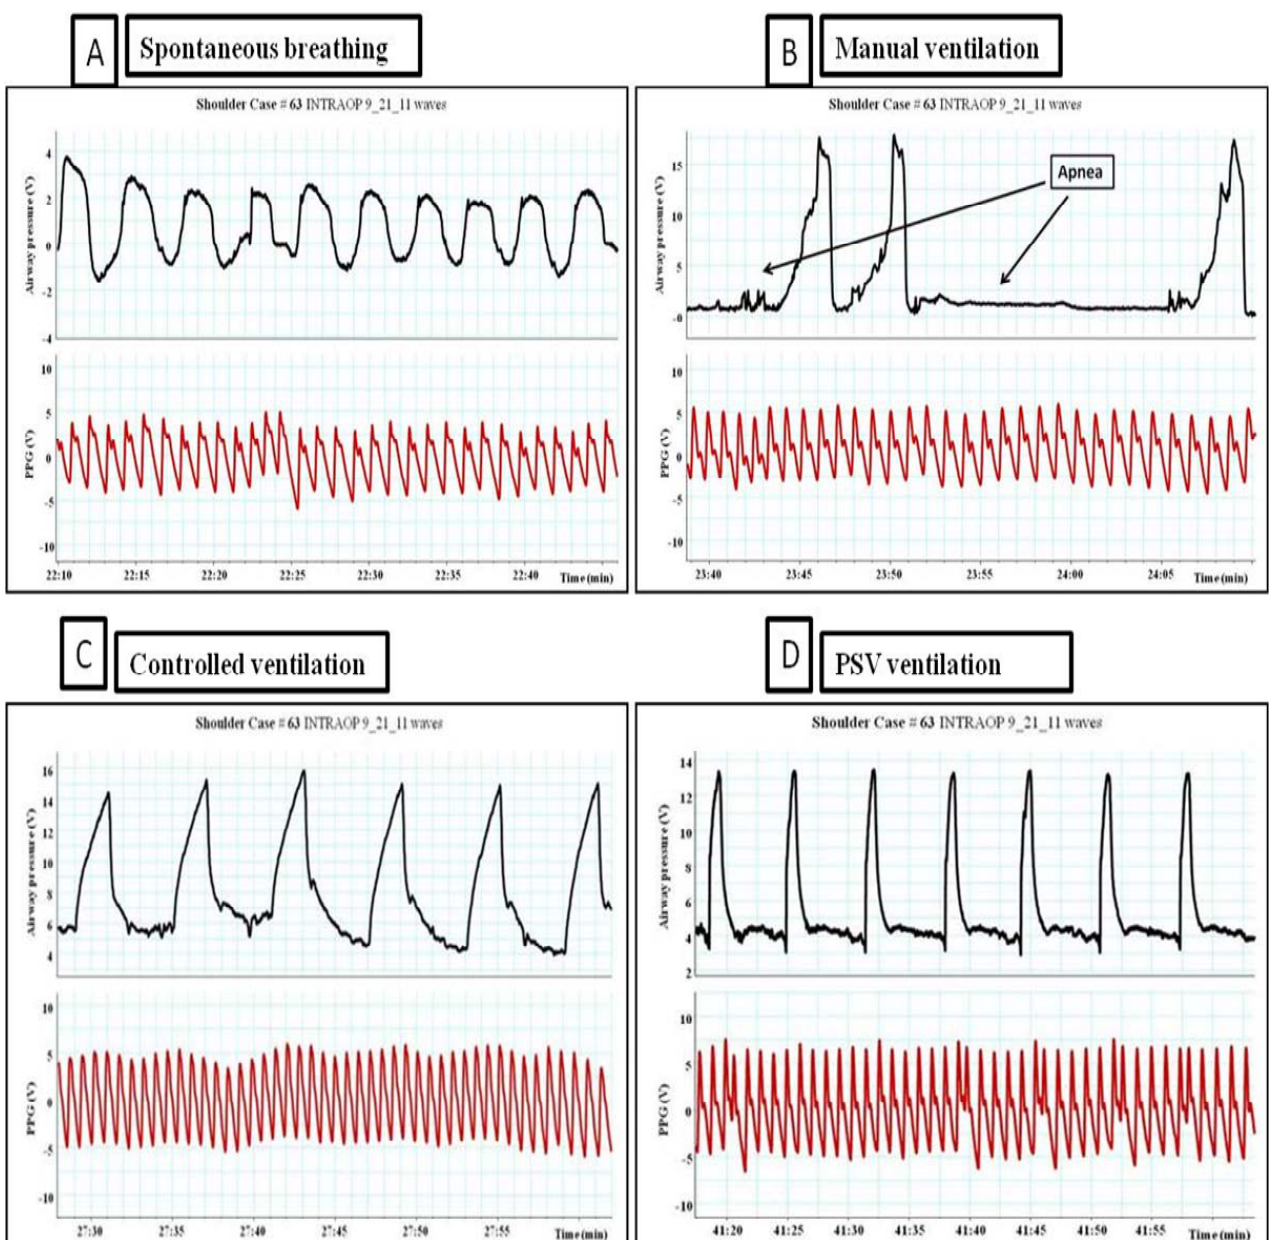
Figure 6. Impact of ventilation on PPG waveforms. ( A ) Spontaneous breathing. ( B ) Manual ventilation with periods of apnea. ( C ) Controlled mechanical ventilation (volume controlled ventilation), tidal volume = 500 cc. ( D ) The impact of PSV ventilation on the PPG waveforms, Peak pressure = 15 cmH O, respiratory rate = 10, tidal volume = 300–350 support = 14 cmH 2